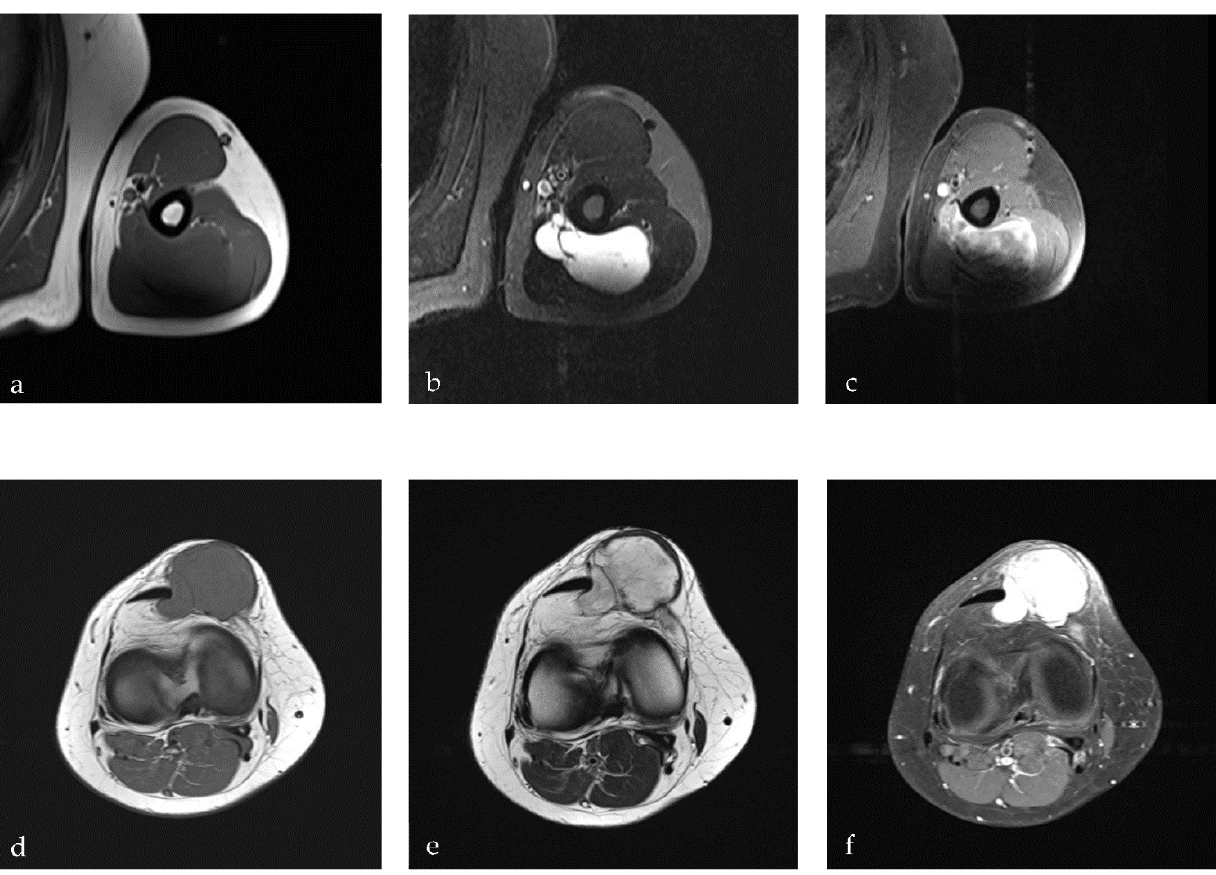
Figure 1. IMM and schwannoma appearance on MRI: ( a ) IMM on T1w sequences; ( b ) IMM on T2w sequences; ( c ) IMM after CM administration; ( d ) schwannoma on T1w sequences; ( e ) schwannoma on T2w sequences; ( f ) schwannoma after CM administration with CM.